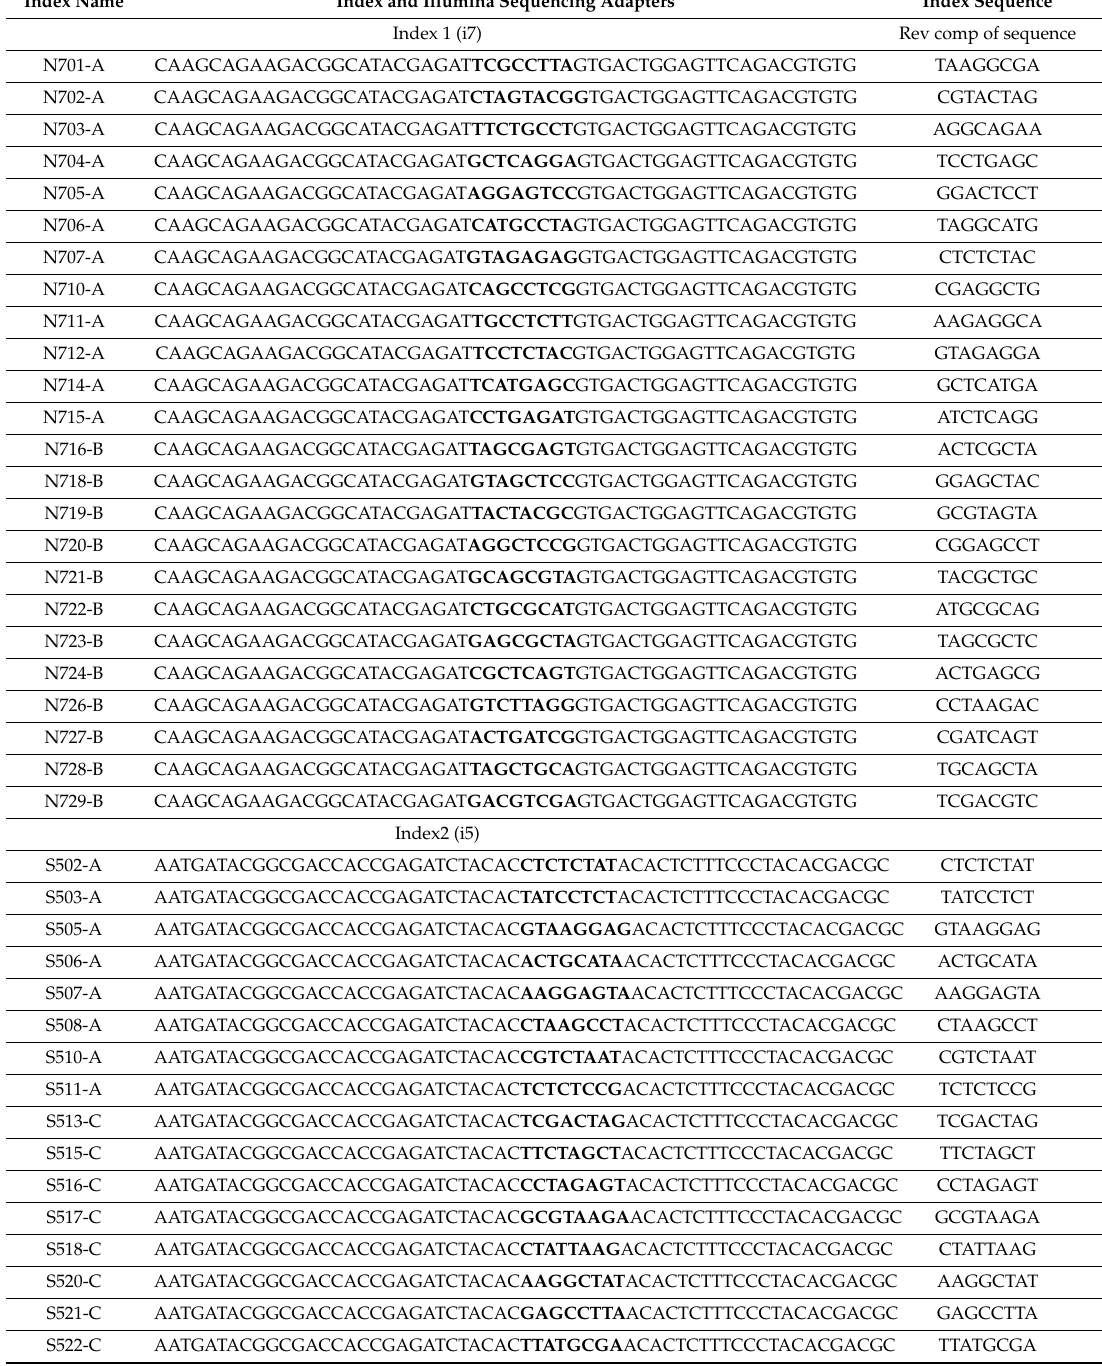
Table A2. List of Illumina Nextera XT v2 index